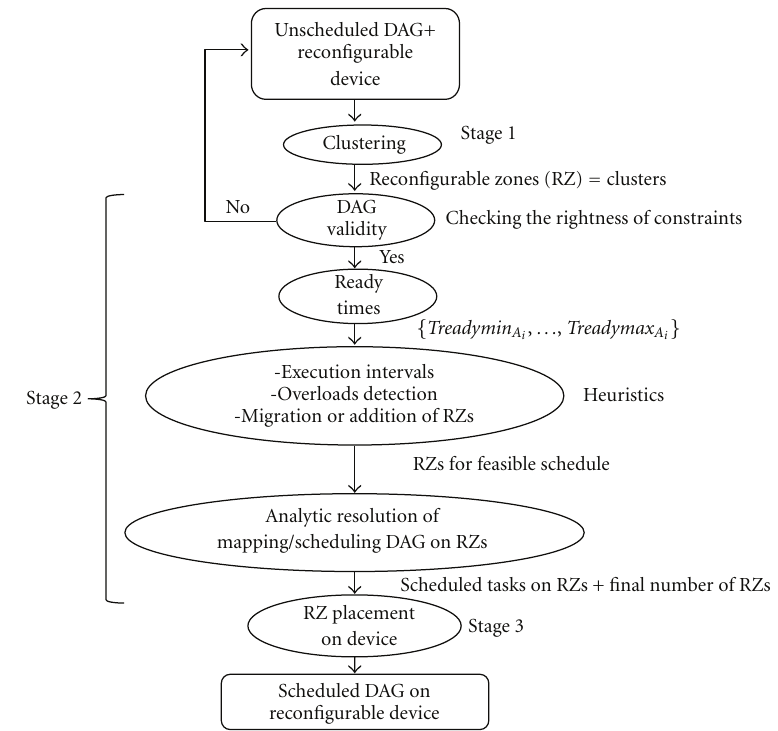
Figure 2: The proposed